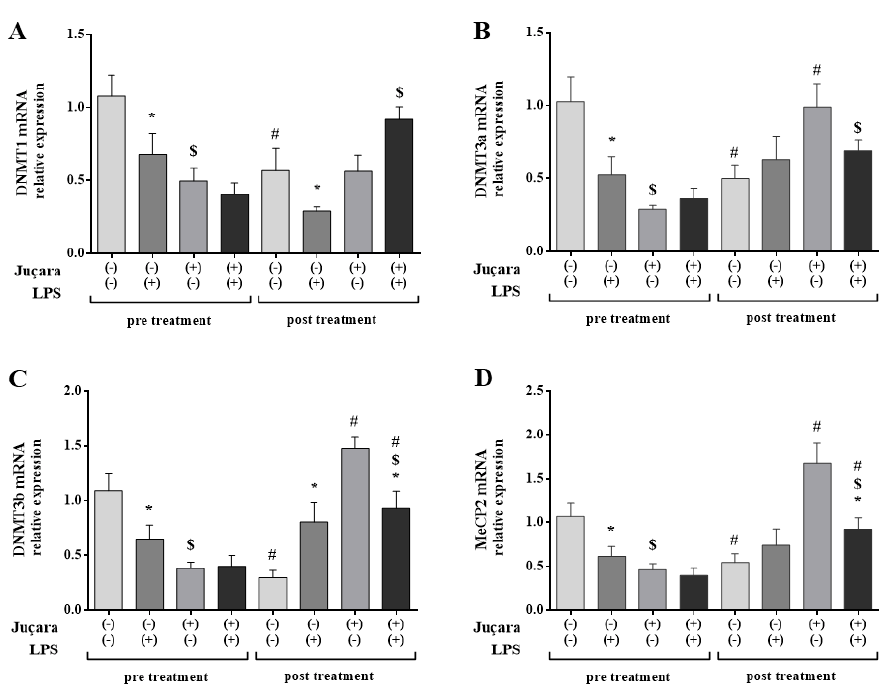
Figure 1. Monocyte epigenetic markers gene expression among groups before and after supplementation: ( A ) DNMT1; ( B ) DNMT3a; ( C ) DNMT3b; ( D ) MeCP2. The housekeeping used for all analyses was the HPRT gene expression. * without LPS versus with LPS; # baseline versus post-treatment; $ placebo versus juçara group. (n = 10 per group).